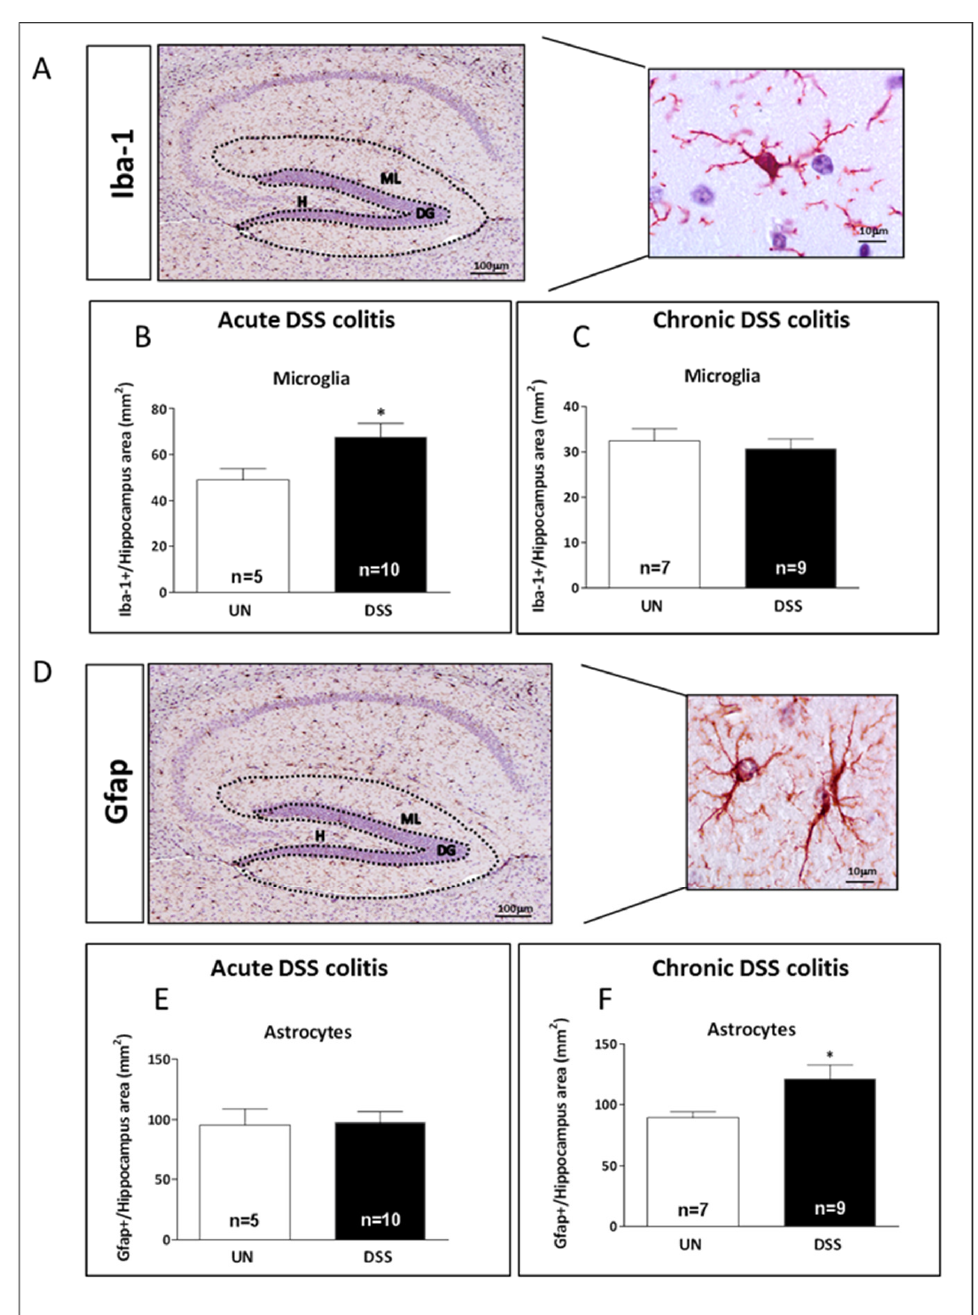
Figure 5. Neuroinflammatory responses in the hippocampus after acute and chronic DSS-induced gut colitis. ( A ) Representative image of Iba-1 immunostaining in specific regions (dashed lines). Quantification of Iba-1 expression level in brain sections of ( B ) acute and ( C ) chronic DSS-treated mice. ( D ) Representative images of Gfap immunostaining in specific regions (dashed lines). Quantification of Gfap expression level in brain sections of ( E ) acute and ( F ) chronic DSS-treated mice. H: hilus, ML: molecular layer; DG: dentate gyrus. The number of mice used per test is indicated in the graphs (n). Data are reported as mean ± SEM, * p < 0.05 for comparison with